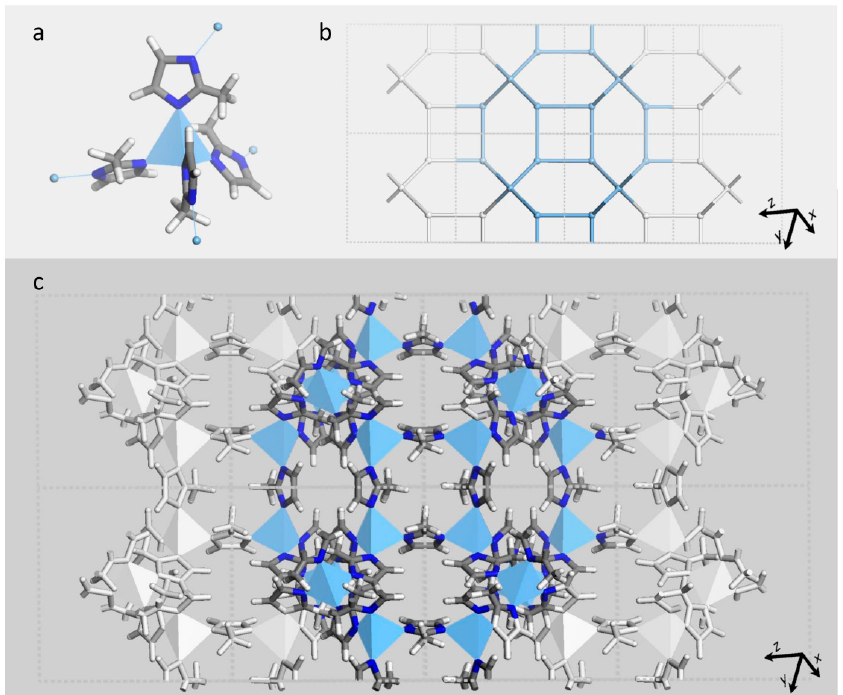
Figure 1. ZIF-8 structure from Ref. [27]. ( a ) Inset on a Zn tetrahedron and the four 2-methylimidazole directly linked to it. Elements are represented according to the following color code: Zn (light blue), N (blue), C (grey), and H (white). ( b ) ZIF-8 structure representation where only the Zn atoms are reported. Only one cage is colored in order to facilitate the visualization. The analogy with the sodalite structure is evident. ( c ) Representation of ( b ) where all the atoms are reported.